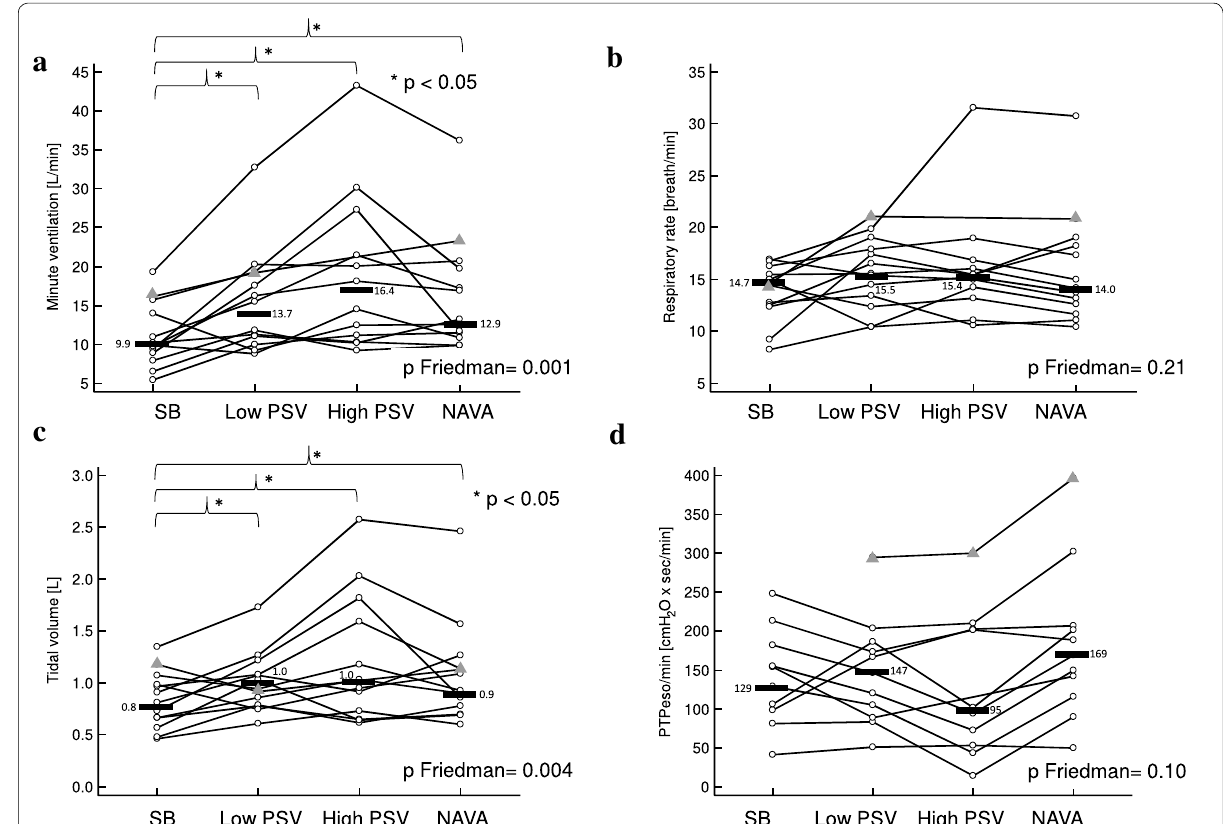
Fig. 4 Effect of unstressed assisted ventilation on MV ( a ), RR ( b ), VT ( c ) and PTPeso/min ( d ). MV minute ventilation, RR respiratory rate, VT tidal volume, PTPeso/min esophageal pressure–time product by minute, SB unstressed (without resistance) spontaneous non‑assisted breathing, PSV pressure support ventilation, NAVA neurally adjusted ventilator assist. The data of all the participants are displayed in the figure. Patients for whom all the conditions were available are represented as white circles. Patients for whom one or more conditions could not be recorded are represented as gray triangles. Only the patients represented as white circles were considered for median calculations and Friedman